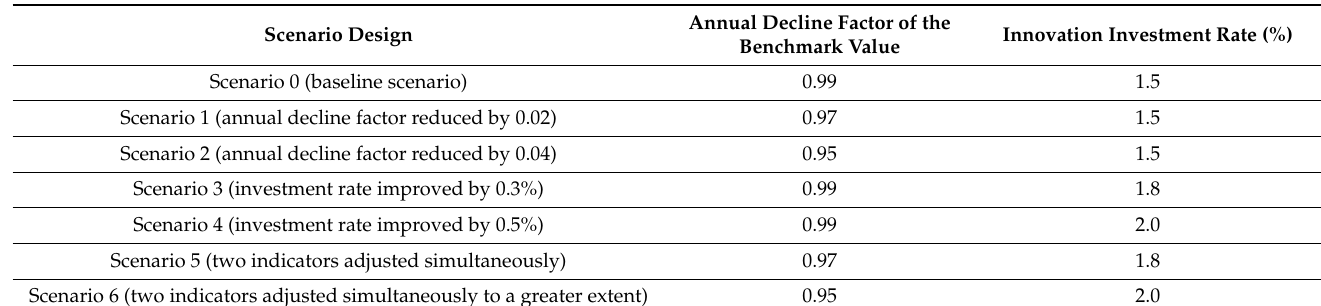
Table 5. Scenario design for the system dynamics